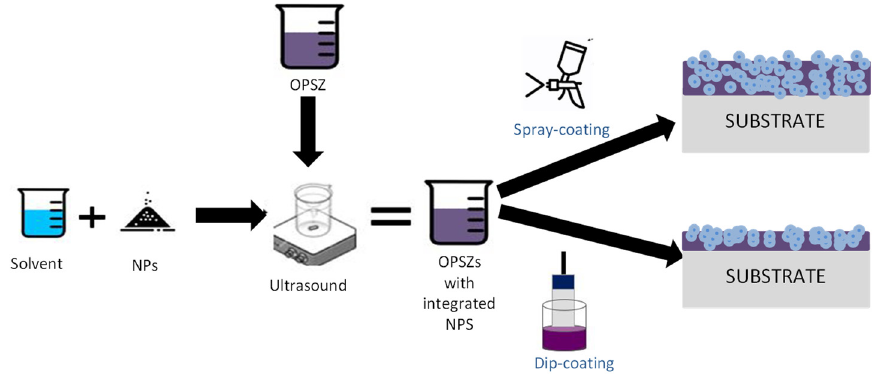
Figure 2. Scheme of the sample preparation process.